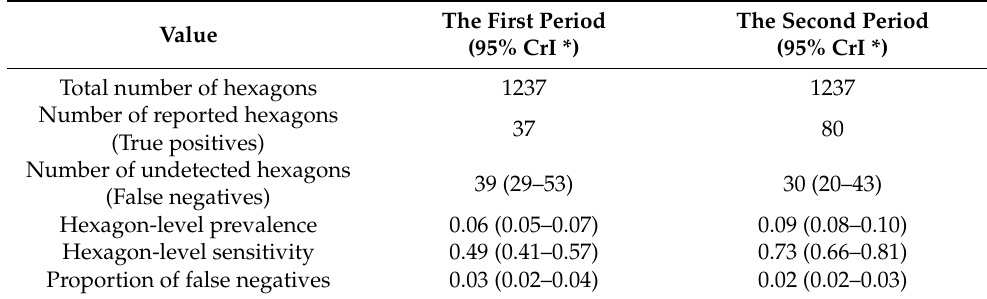
Table 4. The hexagon-level prevalence, sensitivity, and proportion of false negatives for each